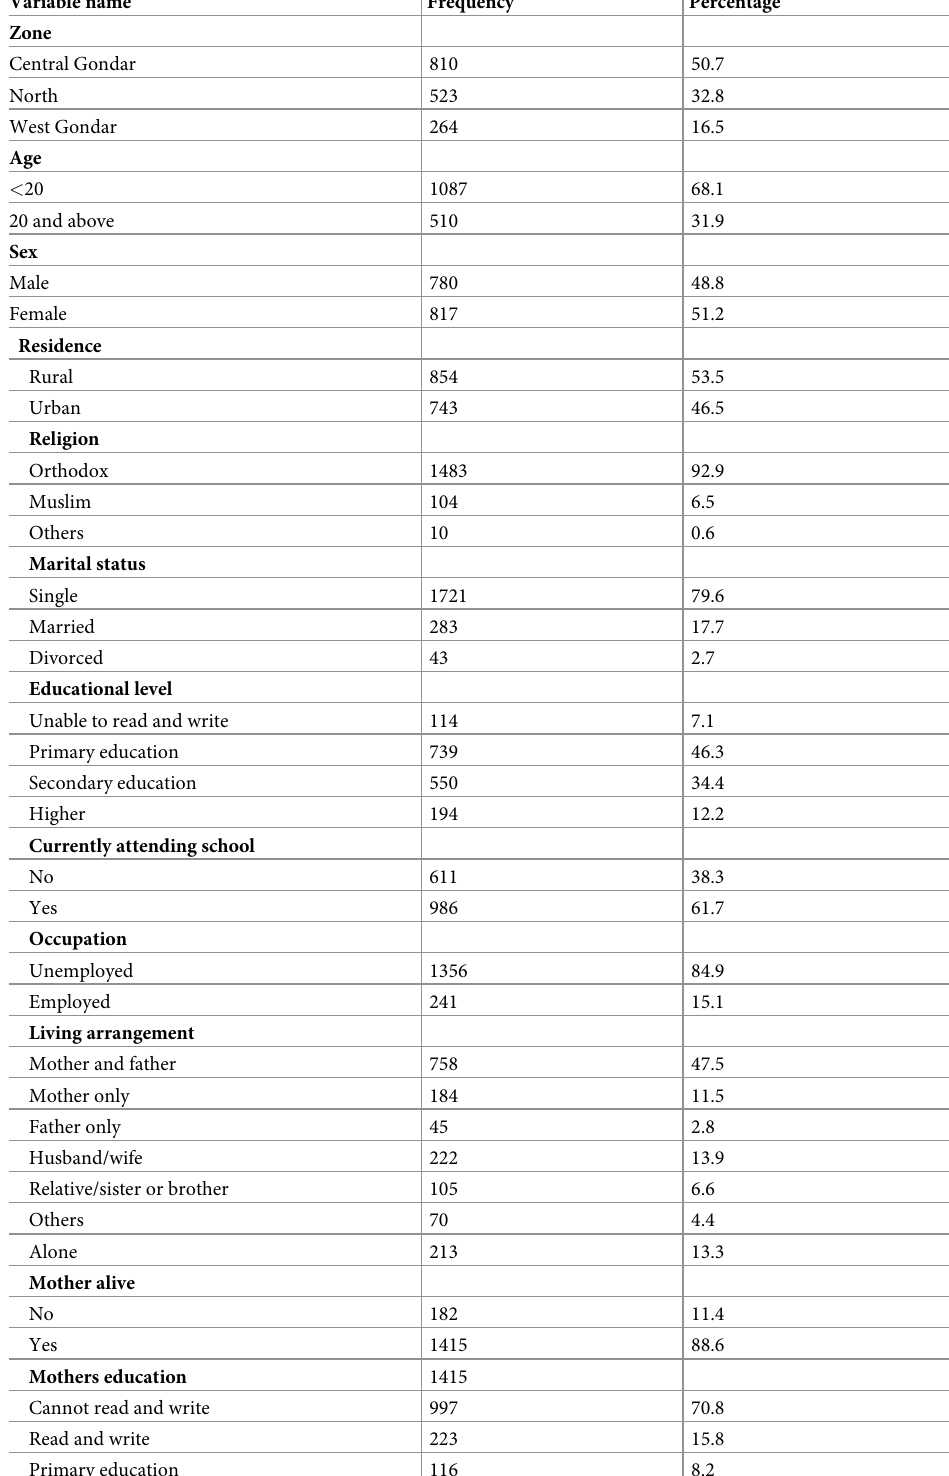
Table 1. Socio-demographic characteristics of youth and youth parent’s Northwest